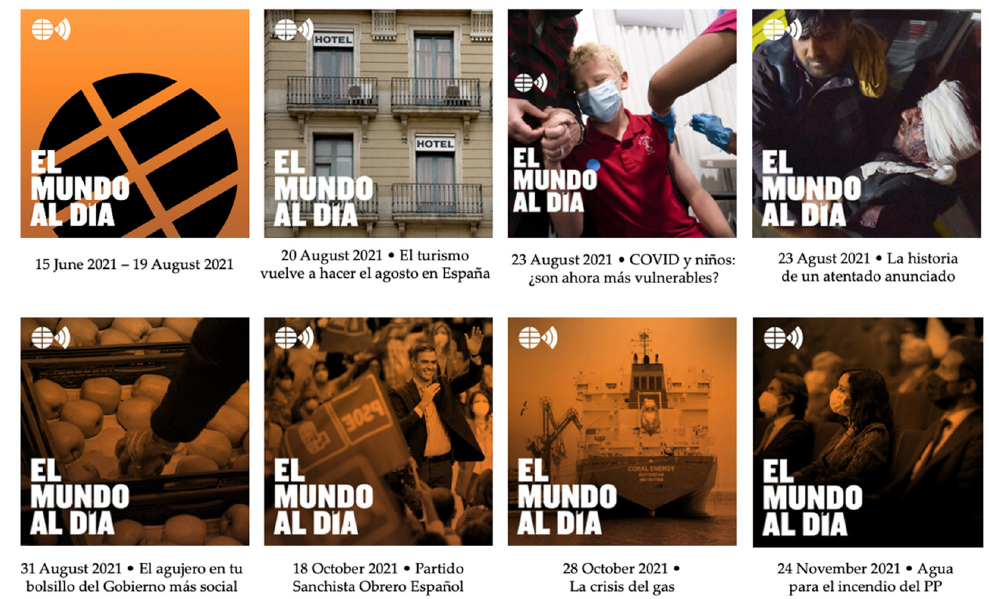
Figure 3. Evolution of the visual aesthetic of the covers of ‘El Mundo al día’. Source: El Mundo.